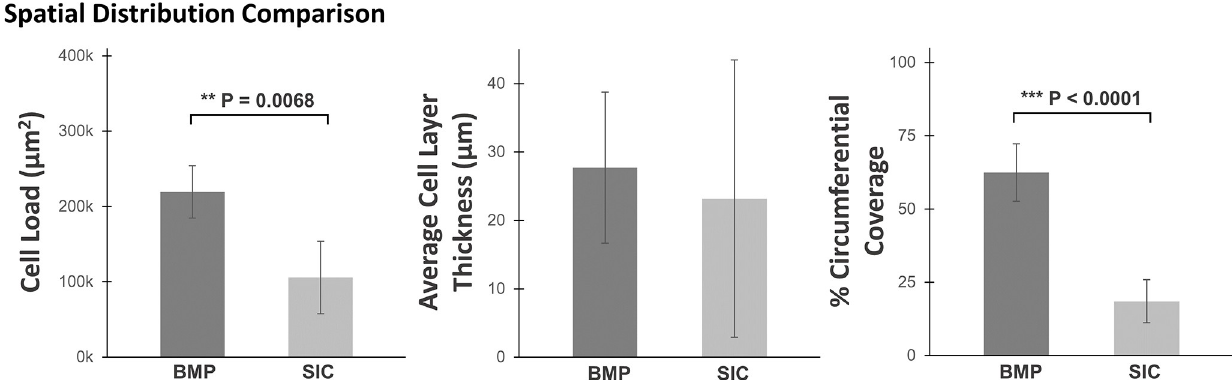
Fig 7. Quantitative assessment of uniformity. Quantitative analysis of H&E images for bioreactor mediated perfusion and static injection counterpart seeding methods preformed with rVSMCs onto electrospun PCL scaffolds. Uniformity judged in terms of total cell load, average cell layer thickness, and % circumferential coverage per section. (n = 20, n = 15; mean ± standard deviation).